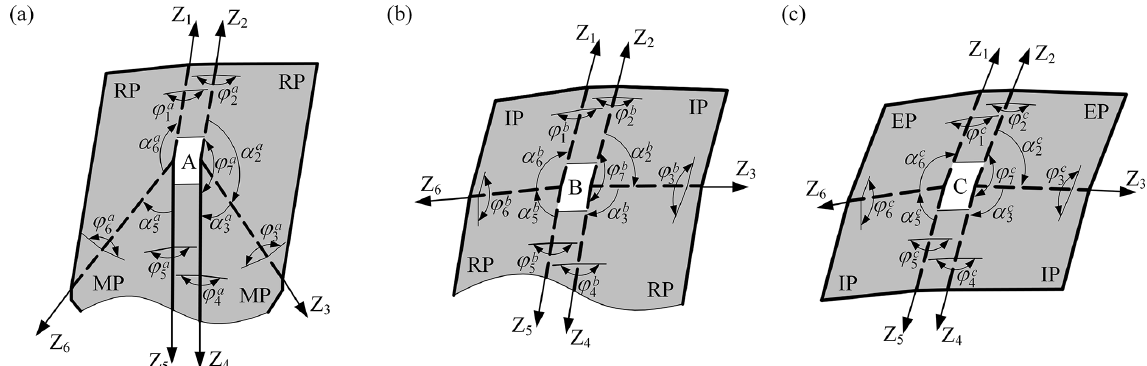
i is the dihedral angle 7